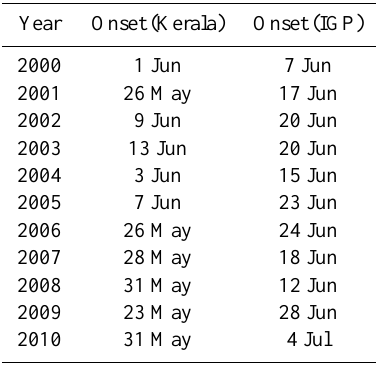
Table 1. Monsoon onset dates over Kerala and